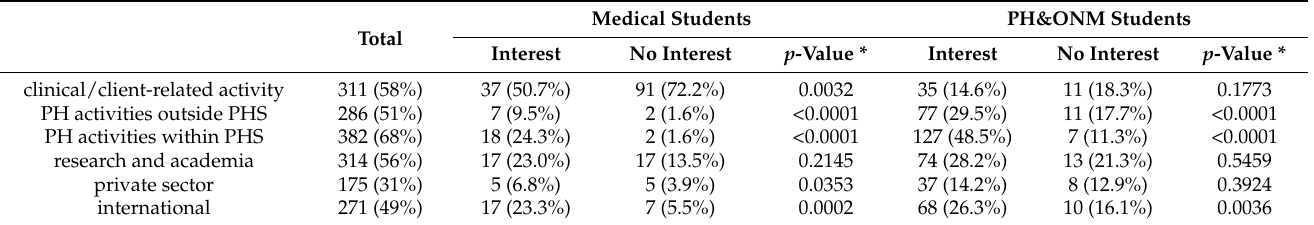
Table A2. Preferred fields of activity after graduation: Absolute and relative proportion of all “Yes, definitely” responses by field of study and PHS interest in wave 2, OeGD-Studisurvey.